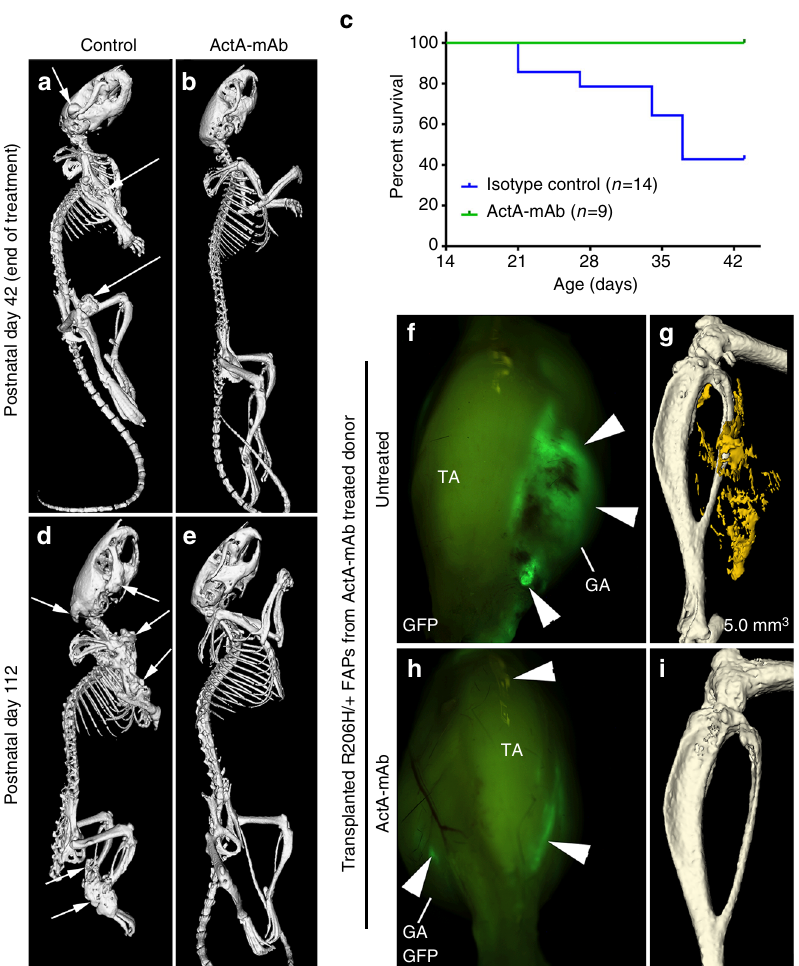
Fig. 5 Activin blockade inhibits FAP-mediated spontaneous HO. a , b Representative µ CT images of 6-week-old Acvr1 tnR206H/ + ; R26 NG/ + ;Pdgfr α -Cre mice treated with 10 mg/kg IgG2a isotype control antibody ( a ) or ActA-mAb ( b ) twice weekly from 14 – 42 days-of-age. Arrows denote sites of HO. c Survival curve of isotype control ( n = 14) and ActA-mAb-treated ( n = 9) mice. Percent survival re fl ects animal deaths as well as mice euthanized due to weight loss of > 20%. d , e Representative µ CT images of 112-day-old Acvr1 tnR206H/ + ; R26 NG/ + ;Pdgfr α -Cre mice either untreated ( d ; n = 1) and heavily burdened with HO of the musculature, tendons/ligaments and jaw (arrows), or 70 days post-cessation of ActA-mAb treatment ( e ; n = 6) and presenting no overt HO. f – i GFP-labeled Acvr1 R206H/ + FAPs were isolated and expanded from 42-day-old Acvr1 tnR206H/ + ; R26 NG/ + ;Pdgfr α -Cre mice ( n = 3) that had been treated with mAb on the day of injury ( h , i ) ( n = 6). f , h Whole mount GFP images showing FAP engraftment (examples at arrowheads). g , i µ CT images at 21 days